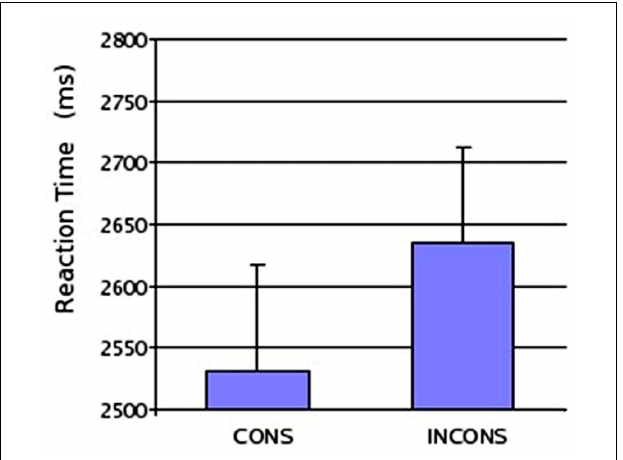
FIGURE 4 | Reaction times on yes–responses in the auditory lexical decision task. The size of the consistency effect was 96ms (CONS, consistent words; INCONS, inconsistent words).